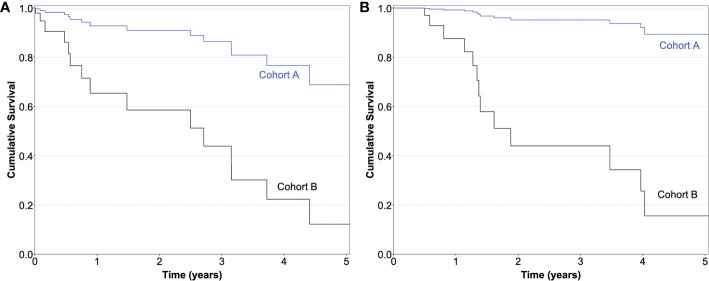

(A) Progression-free survival curves of both cohorts constructed using the final Cox model (adjusted for high-risk histopathology, presence of metastases, and total external beam radiotherapy dose as shown in
Table 3
; model p = 0.000017). (B) Overall survival curves of both cohorts constructed using the final Cox model (adjusted for high-risk histopathology and total external beam radiotherapy dose as shown in
Table 3
; model p = 0.000082).